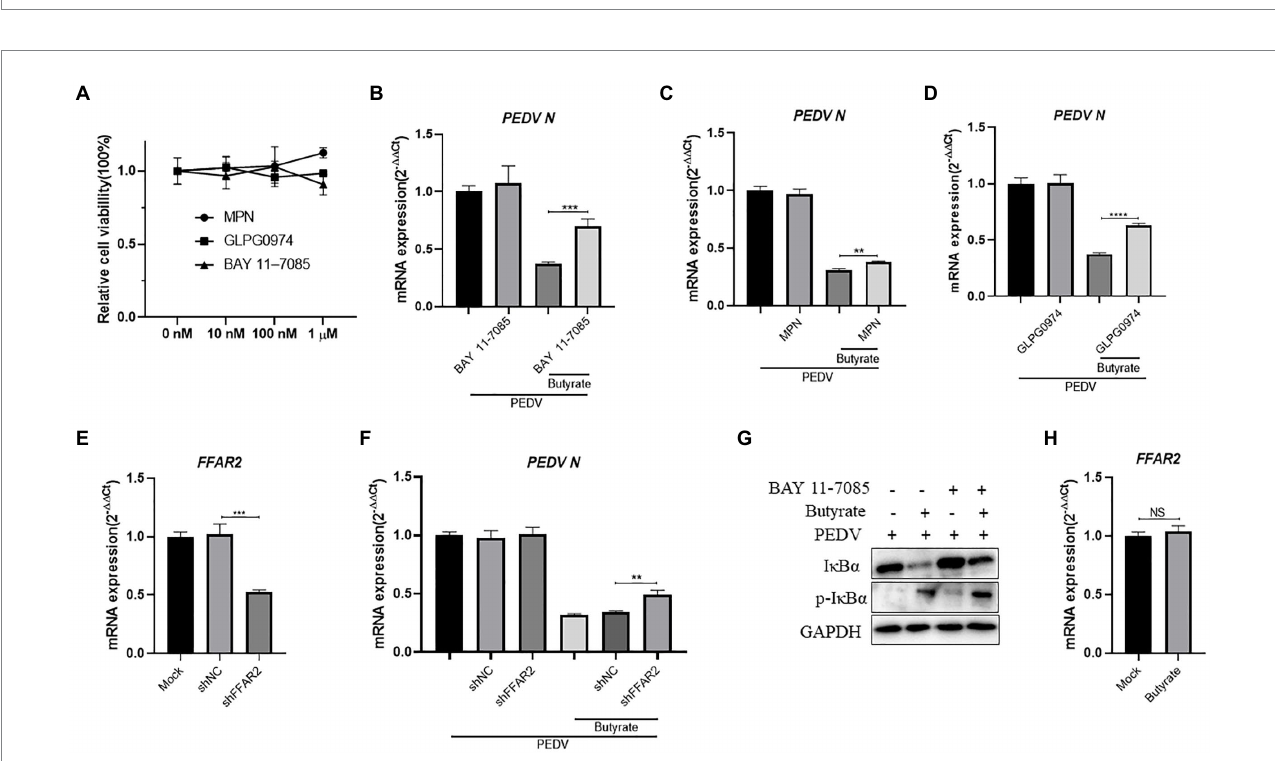
FIGURE 3 Butyrate inhibits PEDV replication via GPR43 and NF- κ B in IPEC-J2 cells. (A) The effect of MPN, GLPG0974, and BAY 11–7,085 on IPEC-J2 cell. Compounds at concentrations of 0 nM, 10 nM, 100 nM, and 1 μ M were added to IPEC-J2 cells and cultured for 48 h. Cell viability was evaluated using the CCK-8 assay. (B) IPEC-J2 cells were treated with 1 mM butyrate and 500 nM BAY 11–7,085 for 24 h and then infected with PEDV. PEDV RNA levels were detected using qPCR. (C) IPEC-J2 cells were treated with 1 mM butyrate and 1 μ M MPN for 24 h and then infected with PEDV. PEDV RNA levels were detected using qPCR (D) IPEC-J2 cells were treated with 1 mM butyrate and 500 nM GLPG0974 for 24 h and then infected with PEDV. PEDV RNA levels were detected using qPCR. (E) IPEC-J2 cells were transfected with FFAR2 shRNA plasmids for 24 h. FFAR2 mRNA expression levels were detected using qPCR. shNC, control shRNA; shFFAR2, shRNA against FFAR2 . (F) IPEC-J2 cells were transfected with FFAR2 shRNA plasmids and pretreated with butyrate for 24 h. PEDV RNA levels were detected using qPCR. (G) IPEC-J2 cells were treated with 1 mM butyrate and 500 nM BAY 11–7,085 for 24 h and then infected with PEDV. Effects of BAY 11– 7,082 on virus-induced phosphorylation of I κ B α . Protein levels detected by western blotting. (H) IPEC-J2 cells were treated with 1 mM butyrate for 24 h. FFAR2 mRNA expression levels were detected using